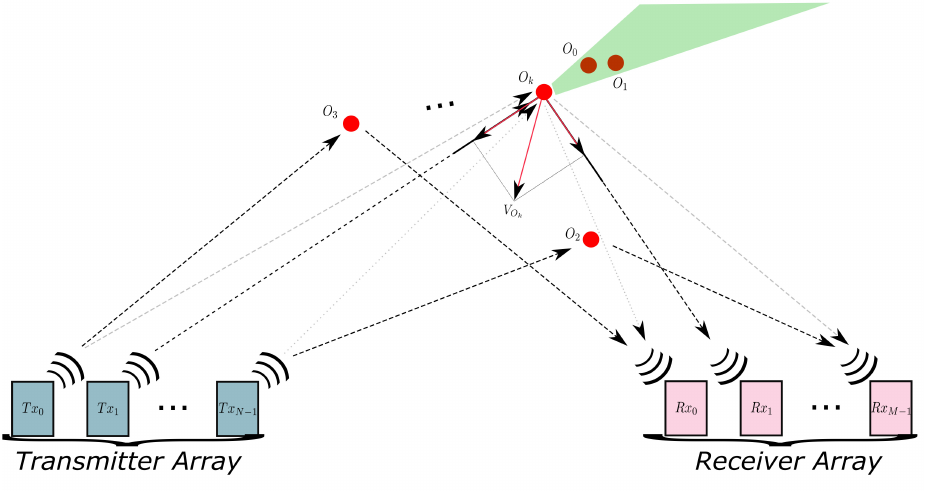
Figure 1. Deep underwater multiple object tracking